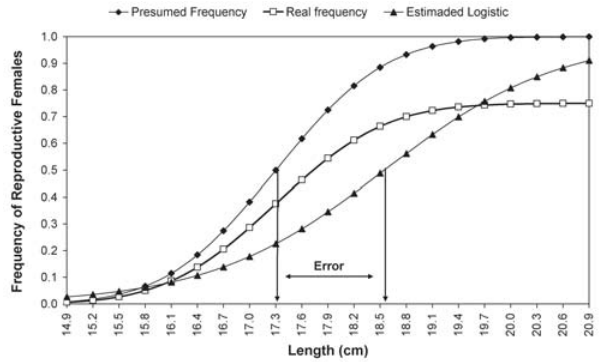
Fig. 2. Logistic curves of relative frequency of reproductive females as function of size class. (black losange) Logistic curve with an asymptote at one and L of 17.3. (white square) 50 Frequencies of reproductive females from the simulation of Fig. 1, considering animals captured in the three months of greatest reproductive activity. In this case, asymptote is at 0.75 (a maximum of 75% of animals could be identified as reproductive). (black triangle) Result from applying a regular logistic, with asymptote at one, to the data of the frequencies of reproductive females from the simulation of Fig. 1.